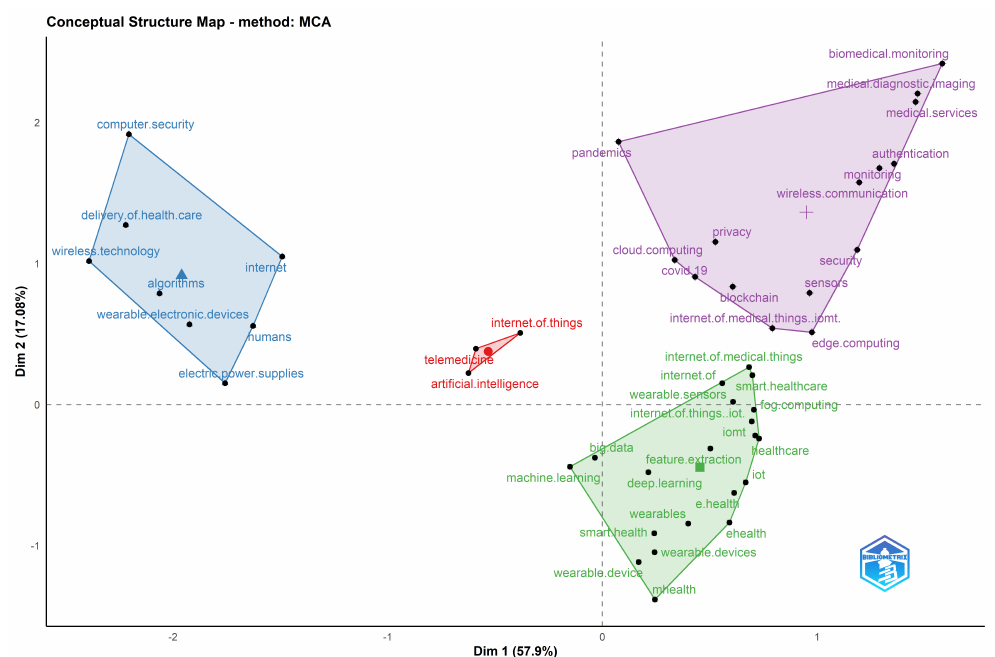
Figure 14. Factorial Analysis using the Biblioshiny package. Clusters are identified by hierarchi- cal